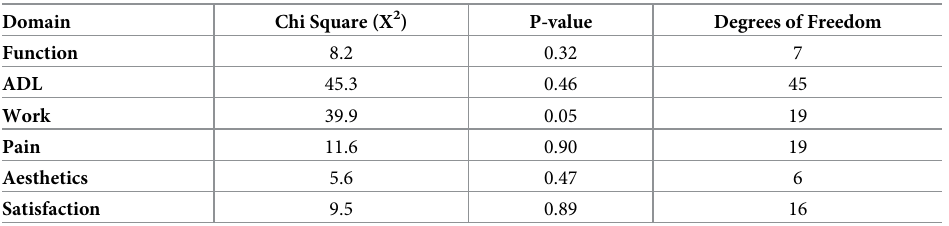
Table 2. Andersen’s conditional likelihood ratio (CLR) for each